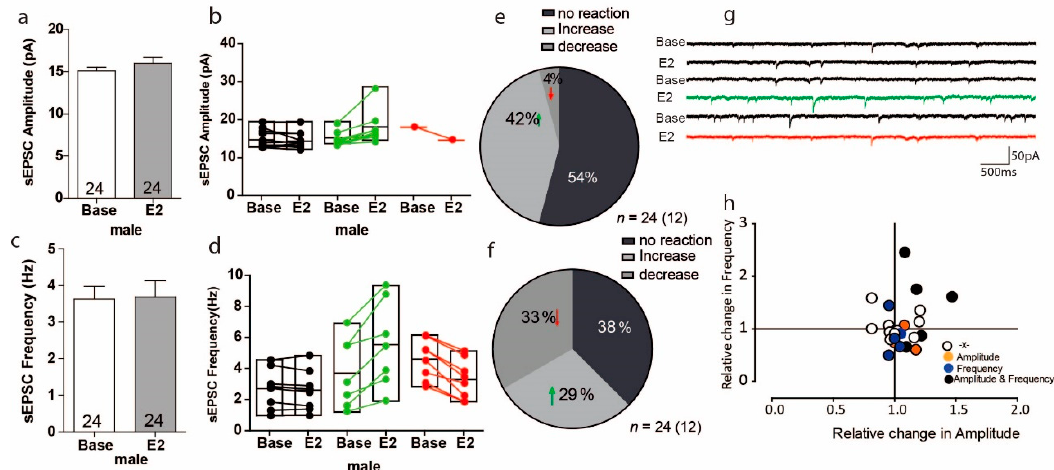
Figure 2. Estradiol causes an opposing reaction in a subset of cells in the PFC of male versus female mice. ( a ) No significant change was found in the average amplitude of sEPSC recordings in the mPFC during baseline and after E2 treatment. ( b ) Plots showing individual sEPSC amplitude responses to E2 during the baseline and after E2 treatment in the same cell. ( c ) The overall response to E2 regarding sEPSC frequency in the mPFC during baseline and after E2 treatment. ( d ) Plots showing sEPSC frequency during baseline and after E2 treatment within-cell analyses. ( e , f ) The proportion of cells with a significant response to E2 treatment. ( g ) Sample traces, frequencies and amplitudes of sEPSCs before and after E2 treatment. ( h ) Plot of the normalized change in sEPSC frequency versus amplitude for each cell; E2 treatment changed sEPSC frequency and amplitude in various ways in different cells.